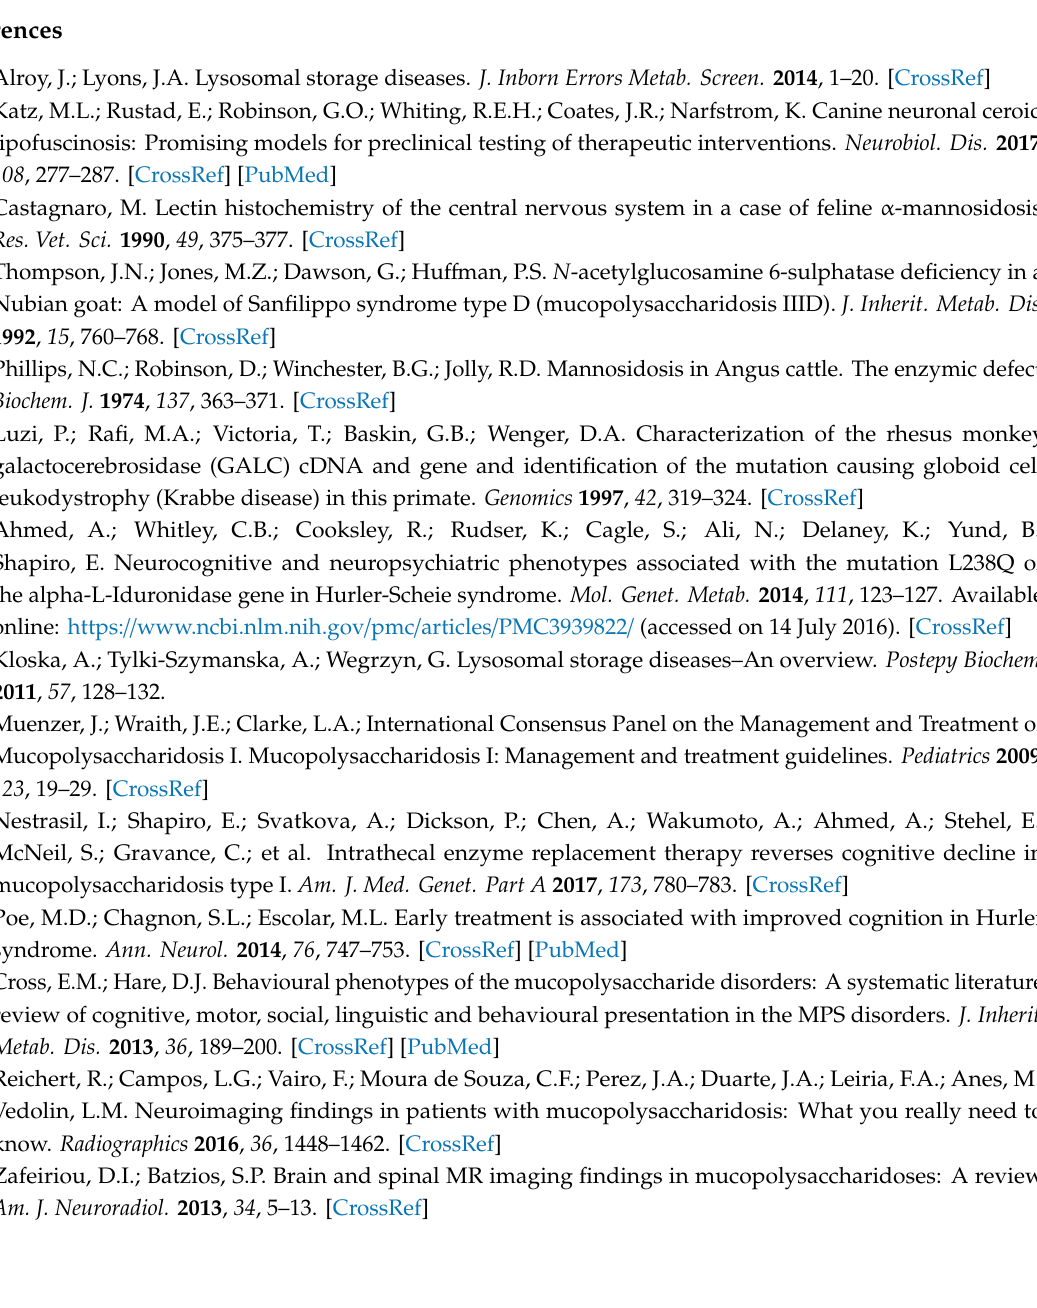
Table S1: Comparison of clinical signs and behavior changes associated with lysosomal storage diseases in dogs and humans [96–123], Table S2: Causes for euthanasia of dogs during